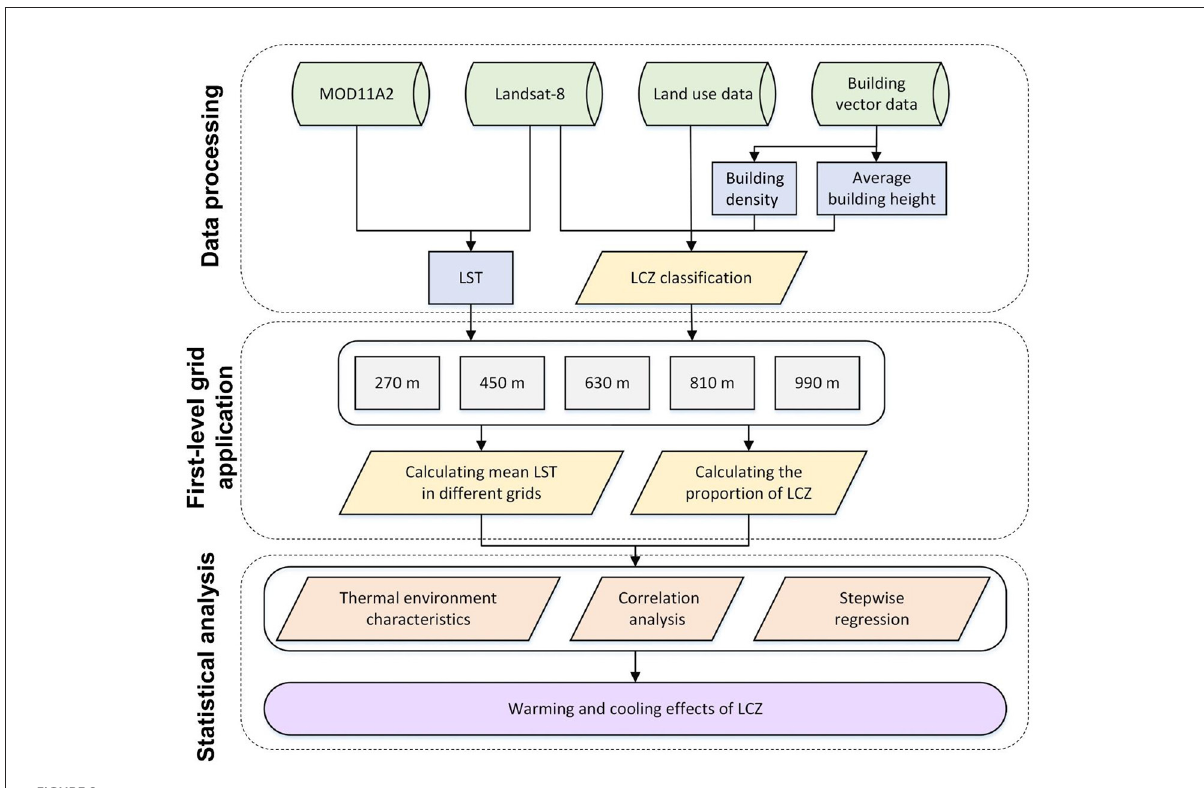
FIGURE2 Research framework.